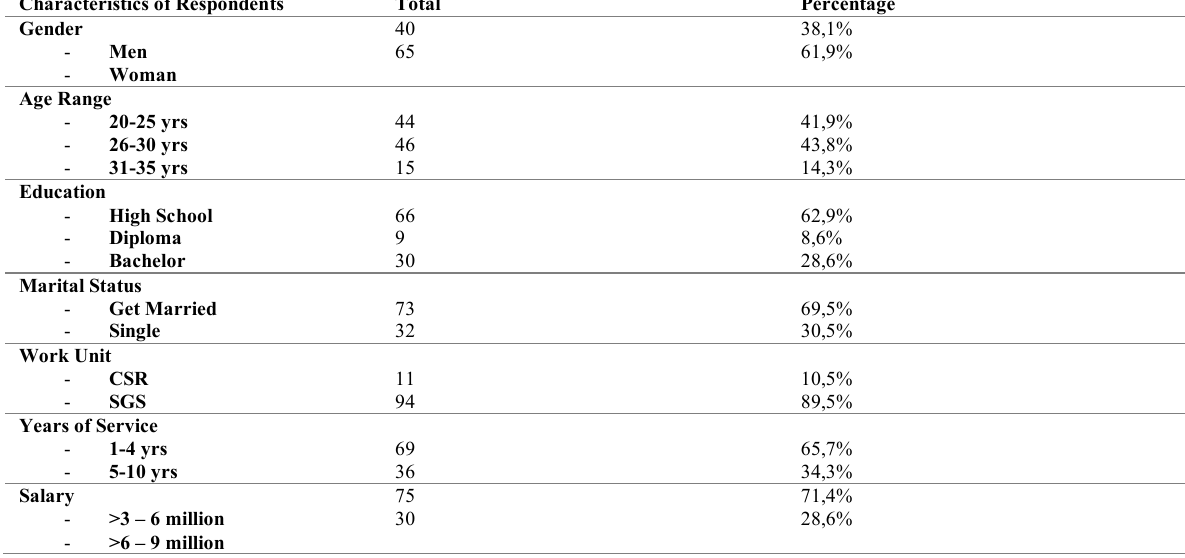
Table 1: Characteristics of the